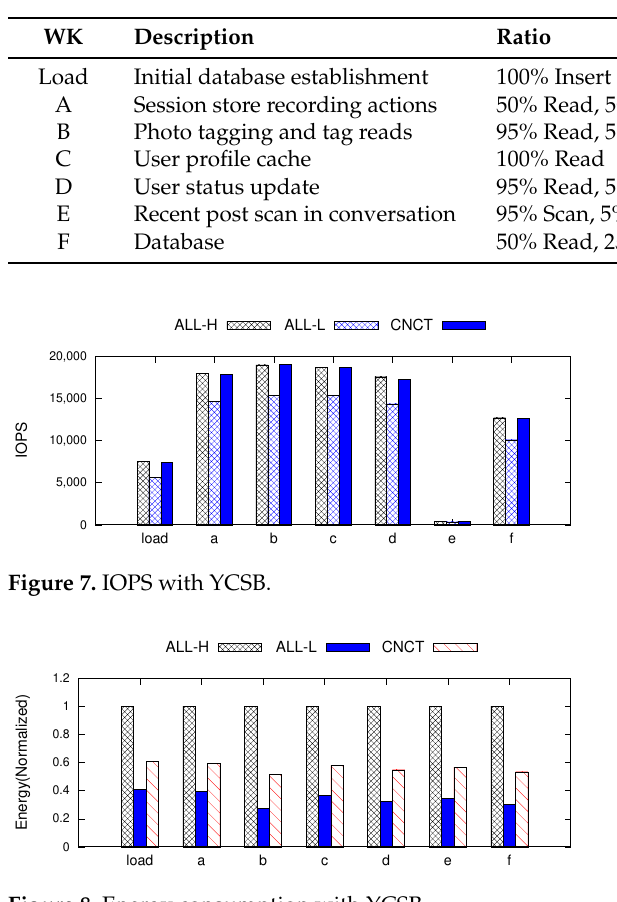
Figure 8. Energy consumption with